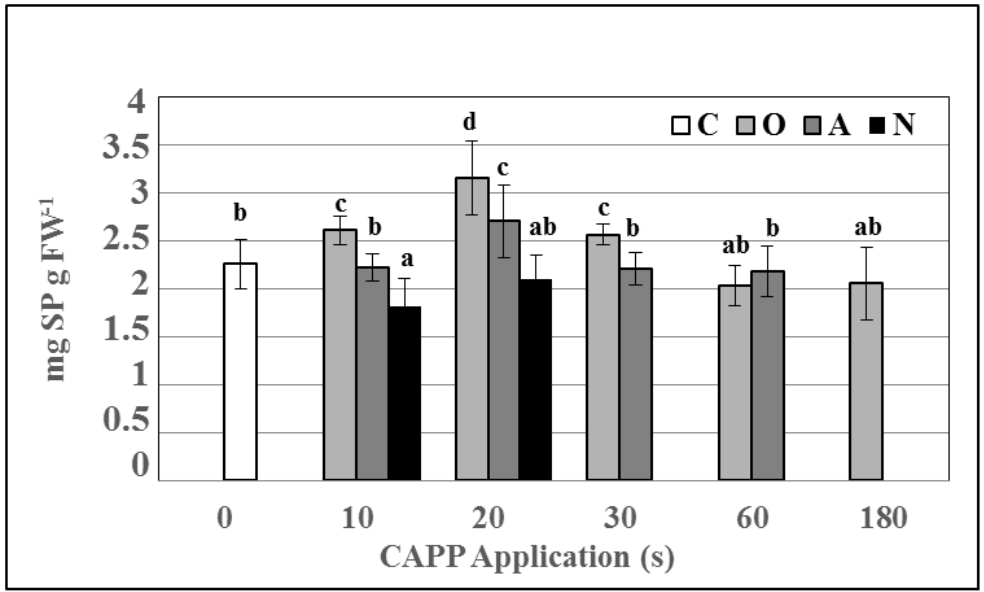
Figure 4. Total soluble protein concentration in 3-day-old barley seedlings after CAPP treatment. Variants: C— control/untreated barley grains; O10–O300: barley grains treated with plasma generated in an oxygen atmosphere for 10, 20, 30, 60, 180 or 300 s; A10–A300: barley grains treated with plasma generated in ambient air for 10, 20, 30, 60, 180 or 300 s; N10–N300 barley grains treated with plasma generated in a nitrogen atmosphere for 10, 20, 30, 60, 180 or 300 s. Different letters indicate significant difference at p -value < 0.05, bars are means of ten experimental runs (one run represents 50 seeds per variant; three 1.5-g mixed samples were analyzed per experimental run and each variant for soluble protein concentration) ± SD according to Tukey’s HSD